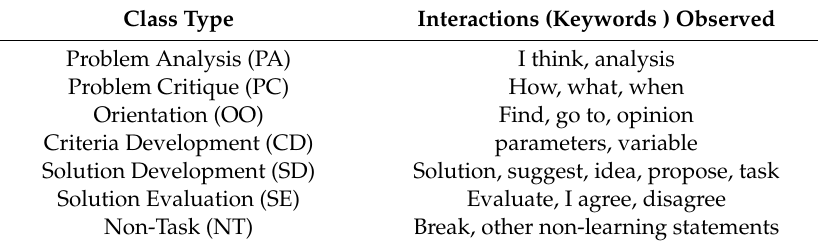
Table 6. Functional Category System (FCS) classes of interactions.